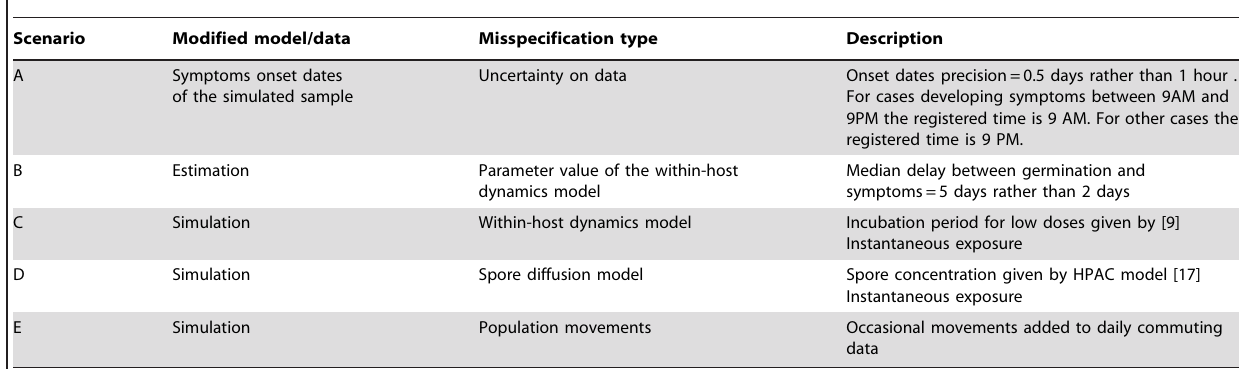
Table 2. Description of